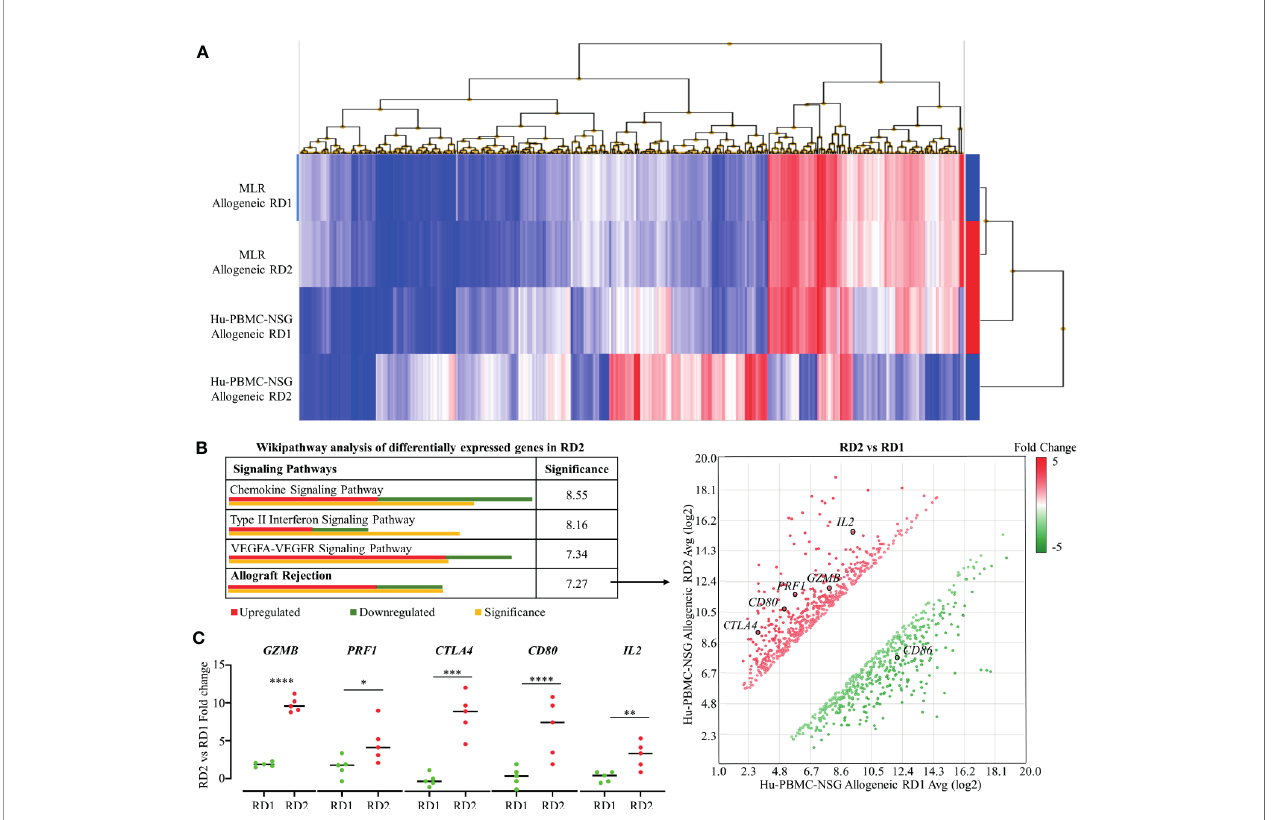
FIGURE 5 | Transcriptome analyses of recipient ’ s allogeneic responses generated in humanized mice demonstrate differences between related donors, which are indistinguishable in the MLR. (A) Human Gene 2.0 ST array was used to plot a heat map representing differential gene expression in hCD3 + T cells of the allogeneic RD1 and RD2 challenges for the MLR and the humanized mouse models. Hierarchical clustering was used to segregate individual gene expression in each group into reduced expression (blue) and over-expression (red) conditions. (B) Transcriptome Analysis Console was used to carry out pathway analysis on the differentially expressing genes in RD2 challenges of the humanized mouse model. The allograft rejection pathway had 12 signi fi cantly upregulated and 7 signi fi cantly downregulated genes depicted in the scatter plot. Signi fi cance was calculated using 2-sided Fisher ’ s exact test. (C) Custom RT-qPCR was carried out to con fi rm fold change of target genes integral for allograft rejection comparing the RD2 vs RD1 allogeneic challenges. n = 5 mice per group. Data presented as mean ± SD. * p < 0.05, **p < 0.01, ***p < 0.001 , ****p <